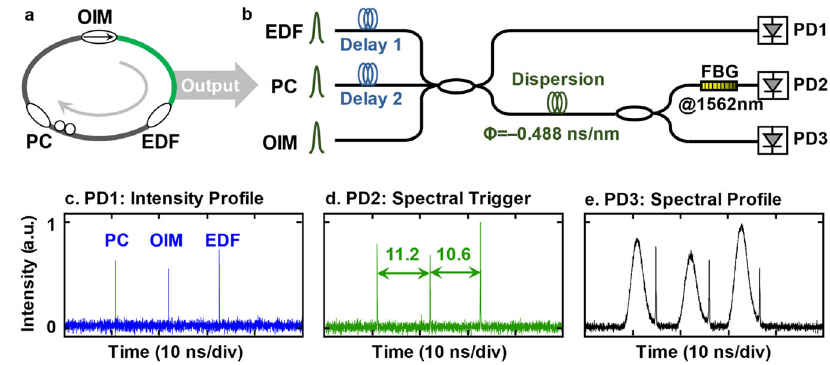
Fig. 2 Experimental setup of multi-port real-time observation. a The laser setup and ( b ) The detection system. Spectra from multi-ports are collected in time division multiplexed sequence. OIM optical integrated module, EDF erbium-doped fi ber, PC polarization controller. PD photodetector, FBG fi ber Bragg grating. c The multiplexed pulses train is well-resolved. d The narrow pulses generated by the FBG are used as the spectral triggers. e The stretched spectra.